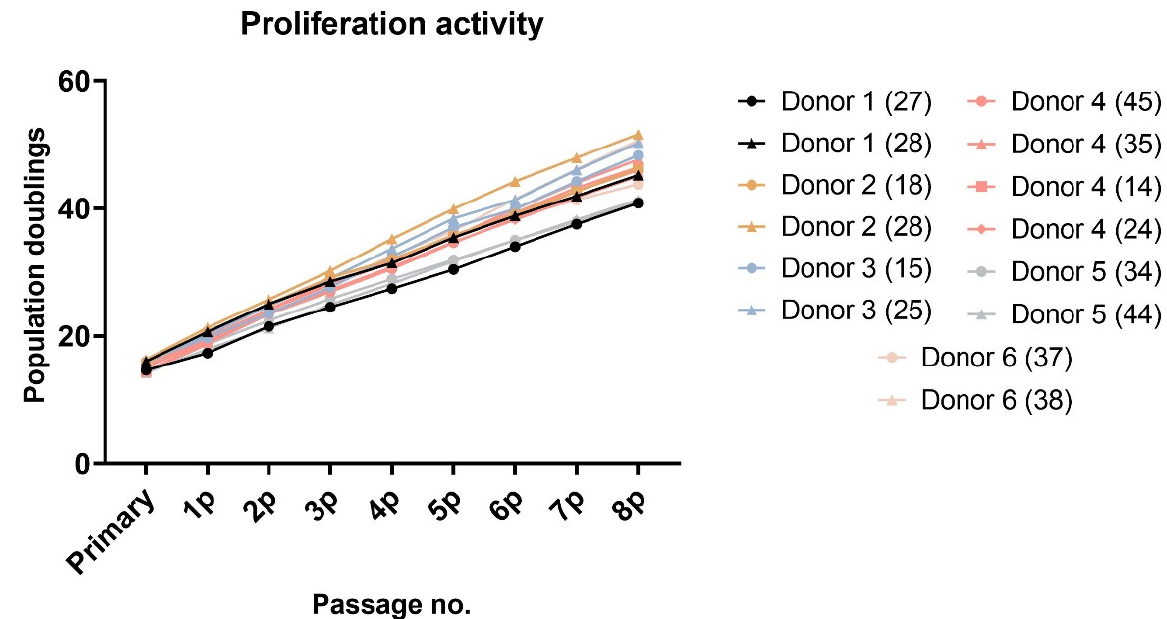
Figure 1. Cumulative population doublings of all paired DPSCs reached from the primary to the 8th passage. We used the formula PD = log 2 (N x /N 1 ) for calculating the population doublings reached in each passage. N x is the total passage cell count calculated using the Z2-Counter (Beckman Coulter, Miami, FL, USA), and N 1 is the initial cell count seeded into the culture dish (5000 cells/cm 2 ). The statistical significance was calculated using a paired t -test; no comparison was statistically significant.